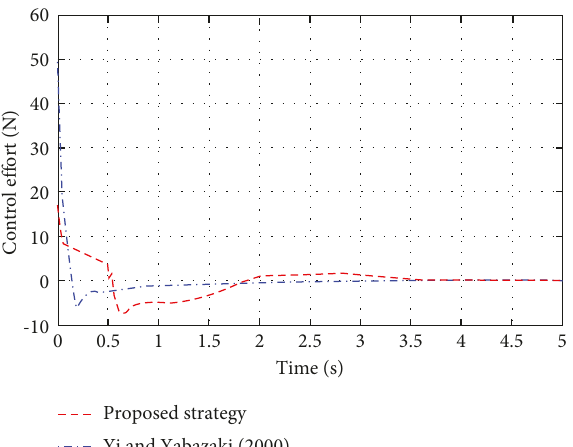
Figure 12: Control efforts based on the suggested fuzzy-PID controller and Yi and Yabazaki’s technique with [ 0 , 0 , 0 , 0 , π /6 , 0 ] initial condition.